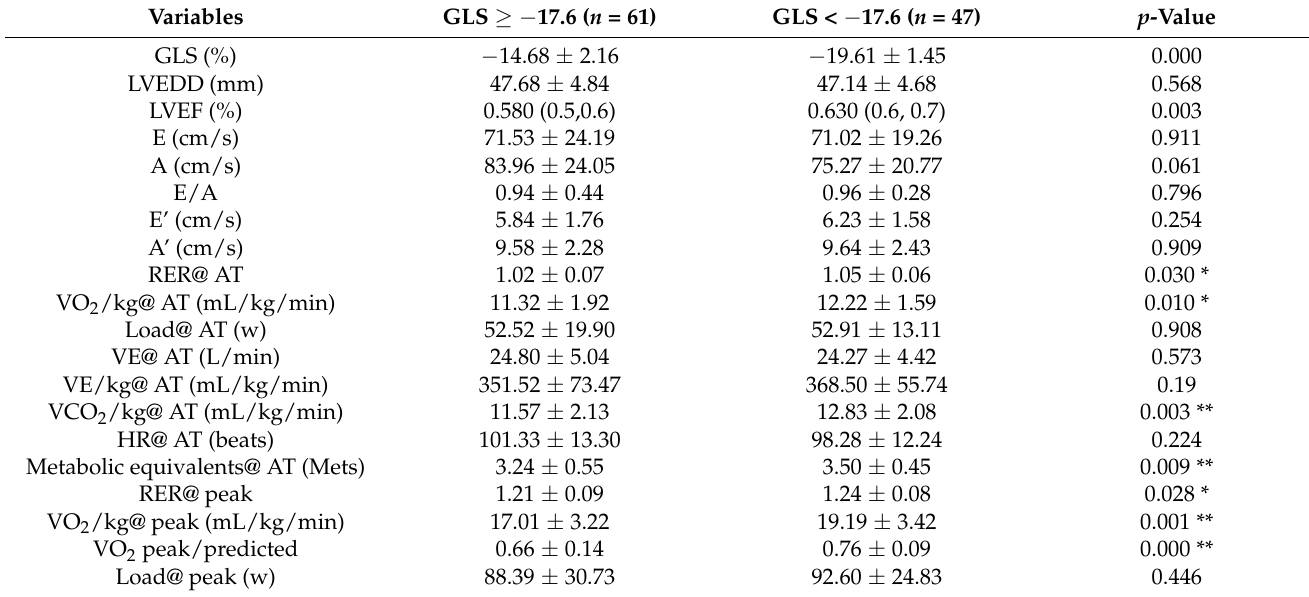
Table 2. Echocardiographic characteristics, global longitudinal strain, and primary CPET variables between